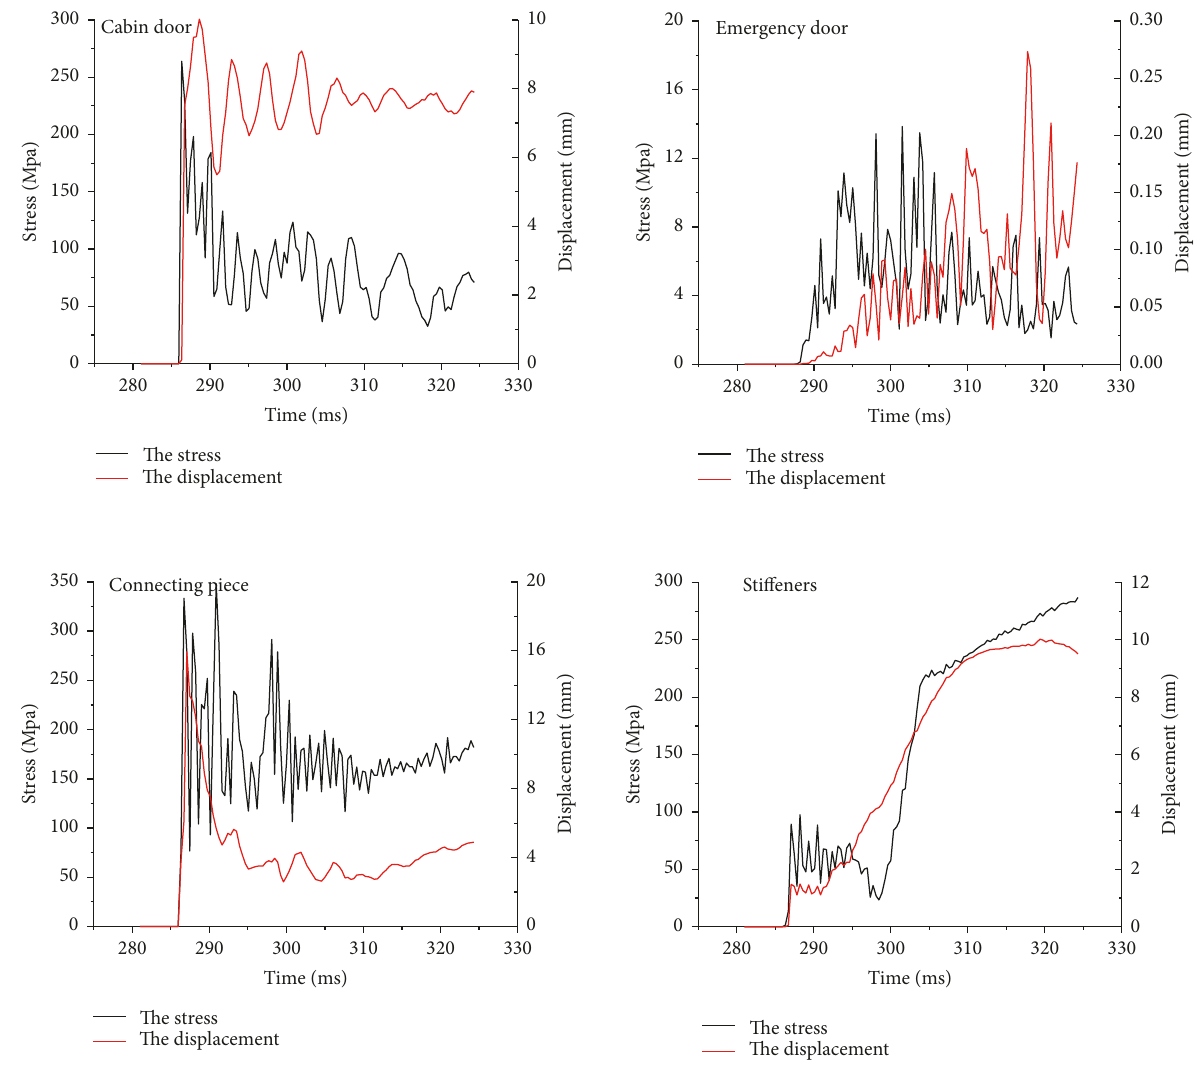
Figure 11: The maximum stress and displacement curves of the key components on the rescue capsule.